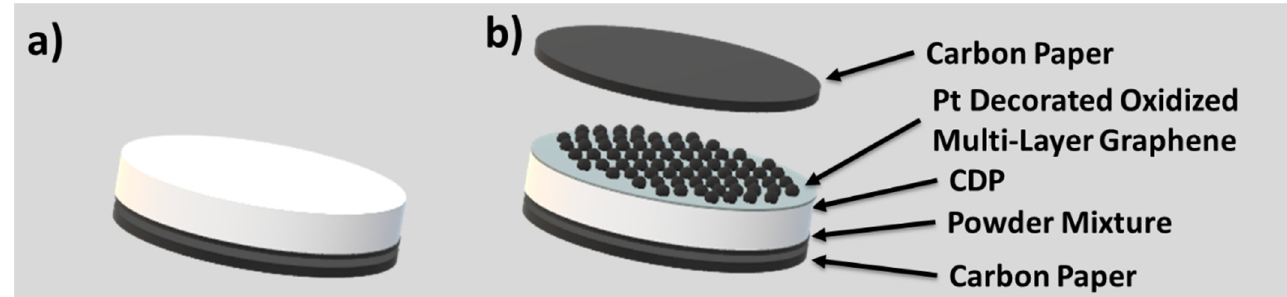
Scheme 2. A cartoon showing the platinum-decorated oxidized multi-layer graphene cell fabrication: ( a ) The first step and ( b ) the second step. For each membrane electrode assembly (MEA) a total of 160 mg·cm − 2 (thickness = 0.6 mm) of the